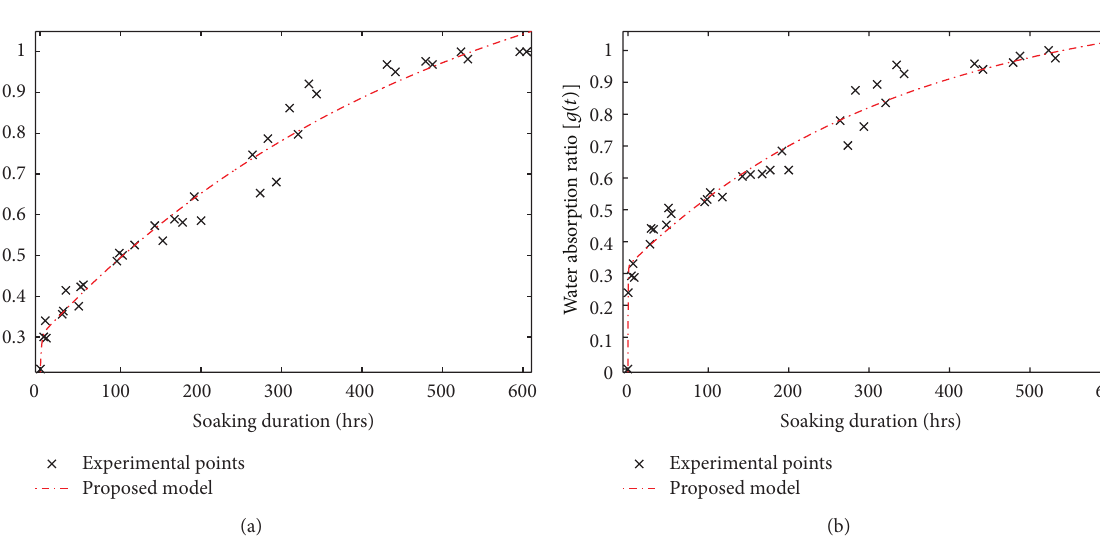
Figure 5: Curve of the proposed model for Raffia vinifera fibres located at the half radius of (a) base of the stem (PL-1/4-R2); (b) after the base of the stem